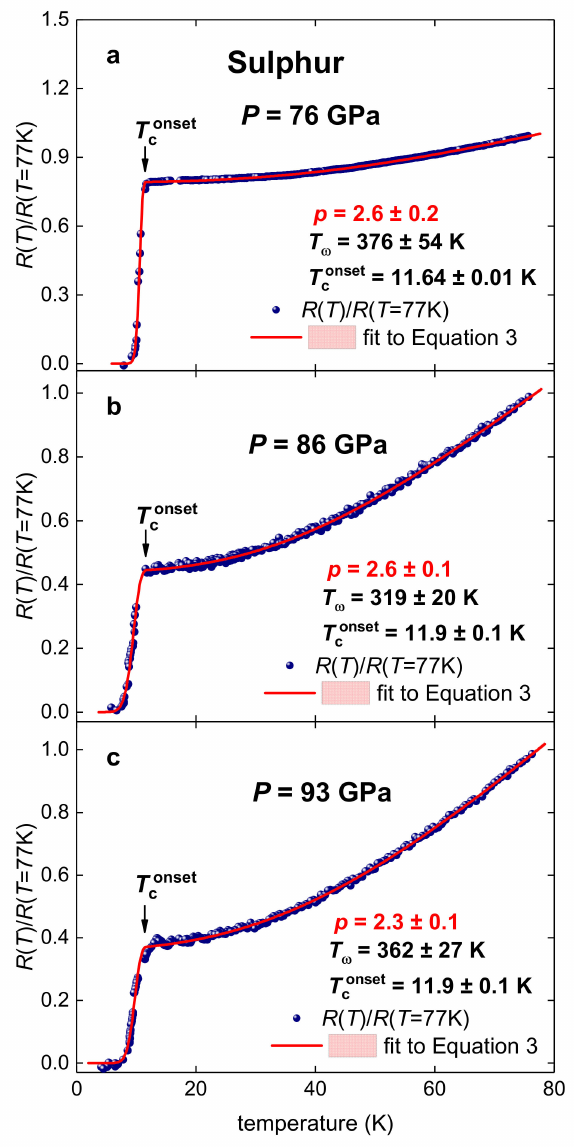
Figure 3. R ( T )/ R ( T = 77 K) datasets for highly compressed sulfur (raw data is from Reference [22]) and fits to Equation (3) at p being a free-fitting parameter. ( a )— P = 76 GPa, deduced p = 2.6 ± 0.2, T ω = 376 ± 54 K, T onset c = 11.64 ± 0.01 K, fit quality is 0.9979; ( b )— P = 86 GPa, deduced p = 2.6 ± 0.1, T ω = 319 ± 20 K, T onset c = 11.9 ± 0.1 K, fit quality is 0.9982, ( c )— P = 93 GPa, deduced p = 2.3 ± 0.1, T ω = 362 ± 27 K, T onset c = 11.9 ± 0.1 K, fit quality is 0.9985. Confidence bands at 95% are shown by pink shadow